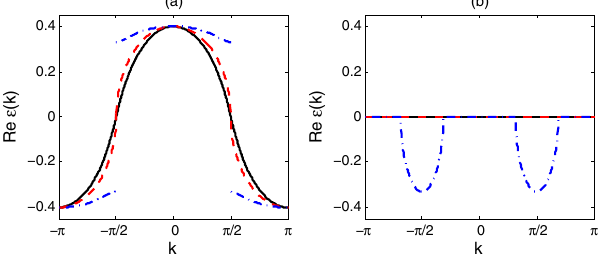
FIG. 5. Real part of ϵ ð k Þ for the same parameters as in Fig.